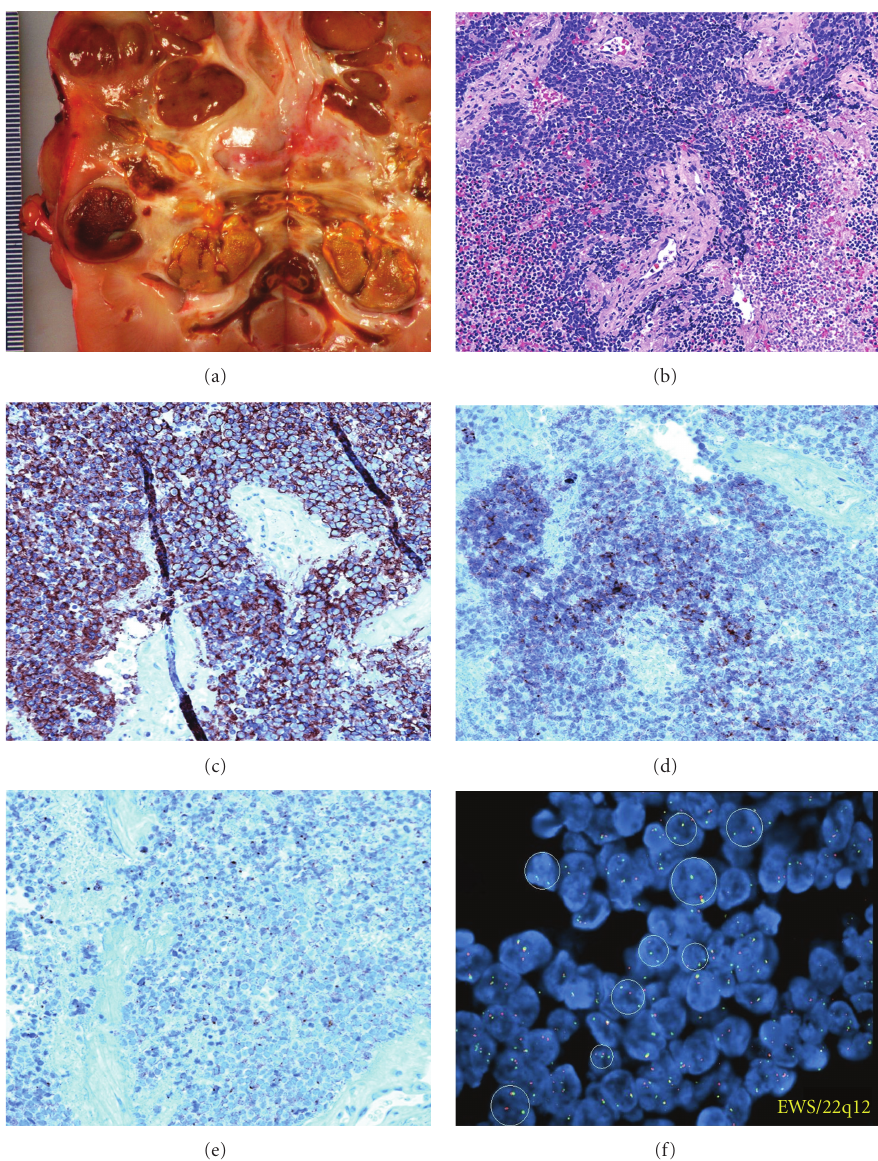
Figure 2: Twenty-one-year-old female. (a) Bivalved right kidney: gross photography showing islands of tan tissue with hemorrhage and necrotic yellow friable areas (center). (b) Microphotography of the right atrial mass removed from the patient showing islands of small blue cells intermixed with necrotic material and blood. (c) The tumor cells showed positive membranous satins for CD99 (DAB X40). (d) Viable tumor cells positive for CD56, note that the necrotic cells are negative (DAB X40). (e) Synapthophysin was positive in the viable neoplastic cells in a cytoplasm dot-like pattern (DAB X40). (f) Fluorescent microphotography: normal cell lacking t(22; q12), a 2-fusion signal pattern is expected to be seen, reflecting the 2 intact copies of EWSR1. In abnormal cell (circle) with t(22; q12), a 1-fusion, 1 green, 1 orange signal pattern will be expected to occur. This confirmed the EWSR1 fusion transcripts in this peripheral primitive neuroectodermal tumor of the